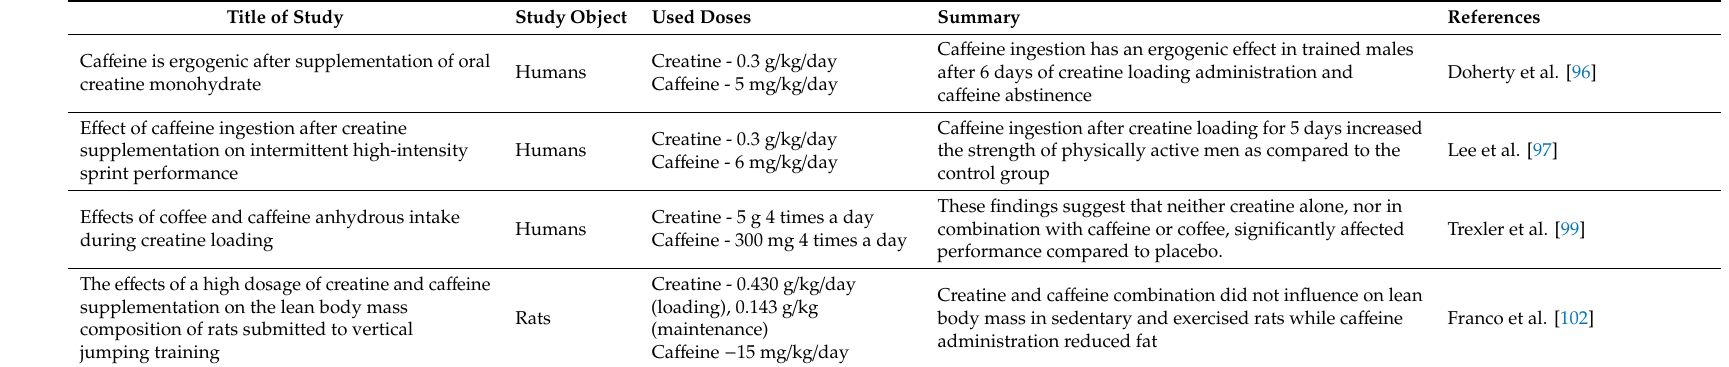
Table 3. Studies including treatment with the combination of Creatine-Ca ff eine in healthy, non-diabetic subjects /